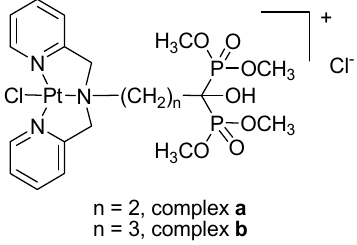
Figure 1. Chemical structures of the designed platinum complexes.